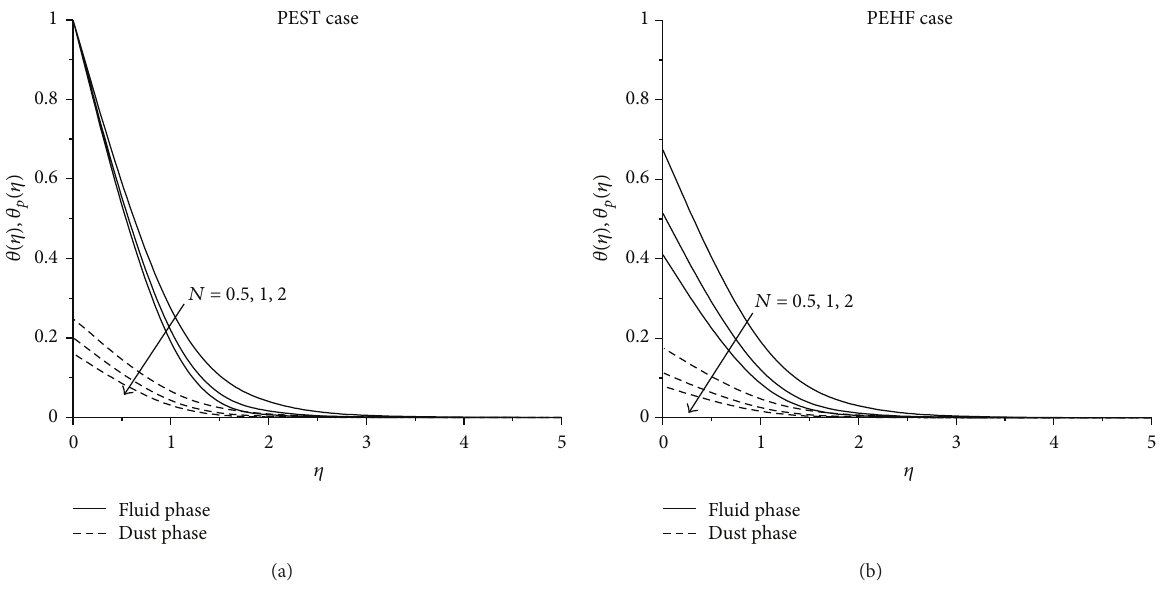
Figure 7: Effect of 𝑁 on temperature profiles for both PEST and PEHF cases with 𝑆 = Ec = 𝜆 = 0.5 , Pr = 0.72 , and 𝛽 = 0.6 .